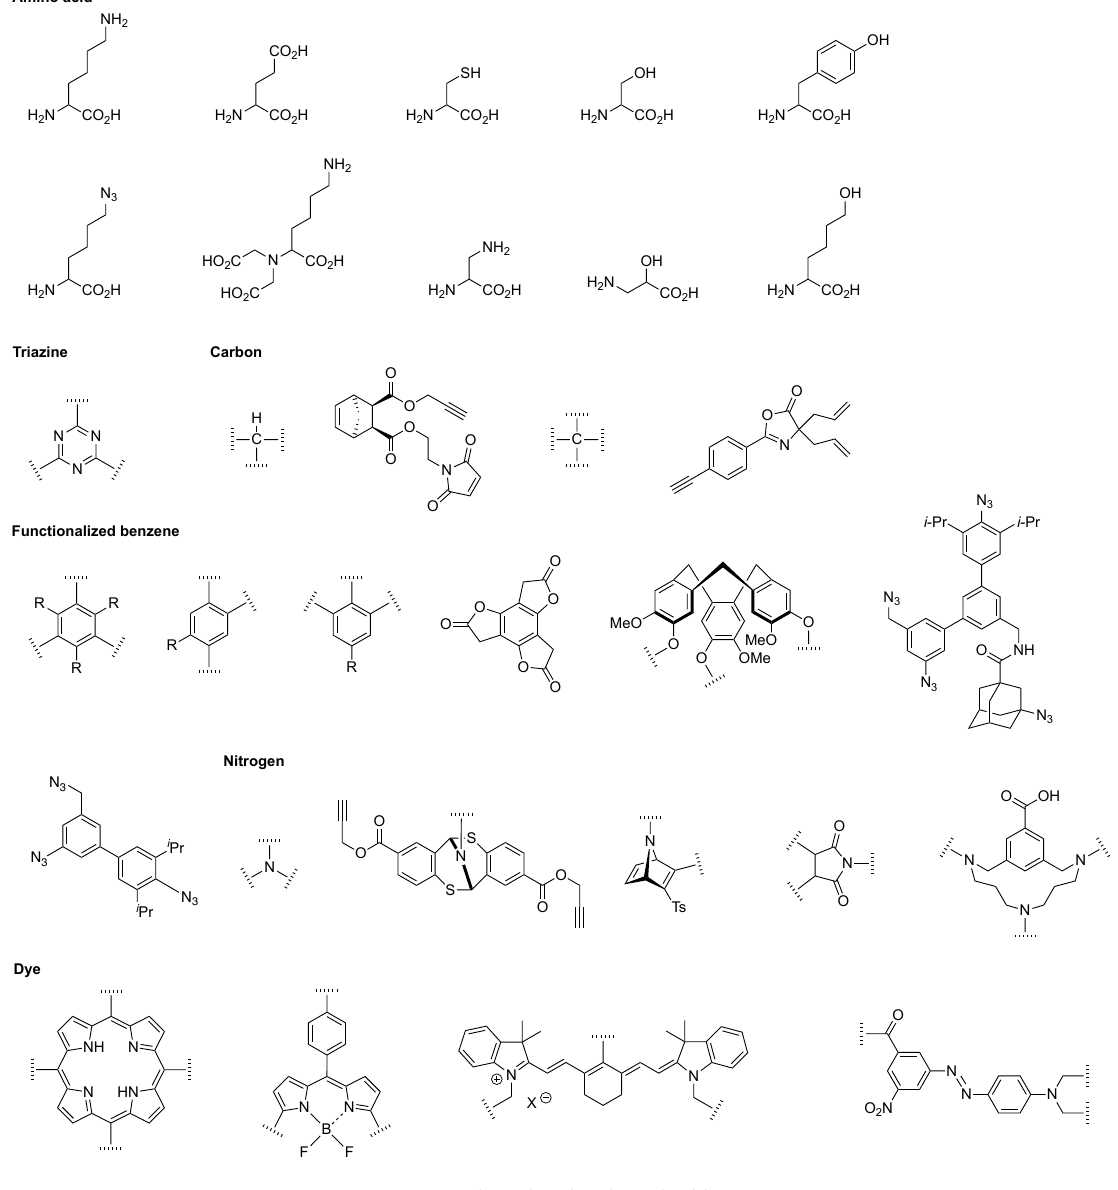
Figure 3. Hub molecules described herein.